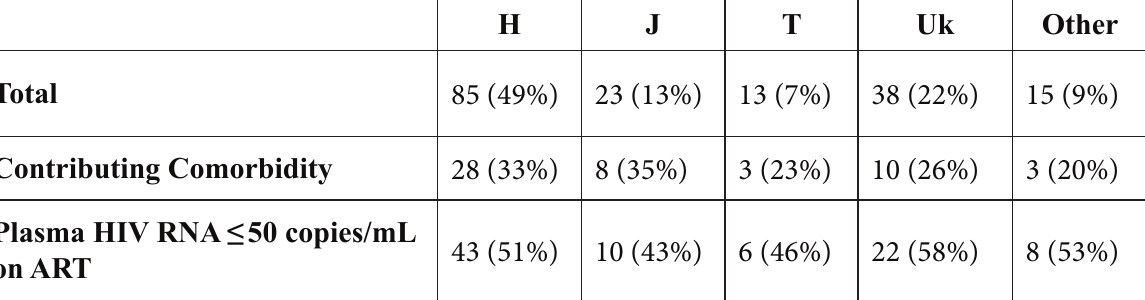
Supplementary Table 2. Distributions of the populations for the secondary analyses in the par- ticipants of European ancestry, broken out by major haplogroups H, J, T, and Uk.